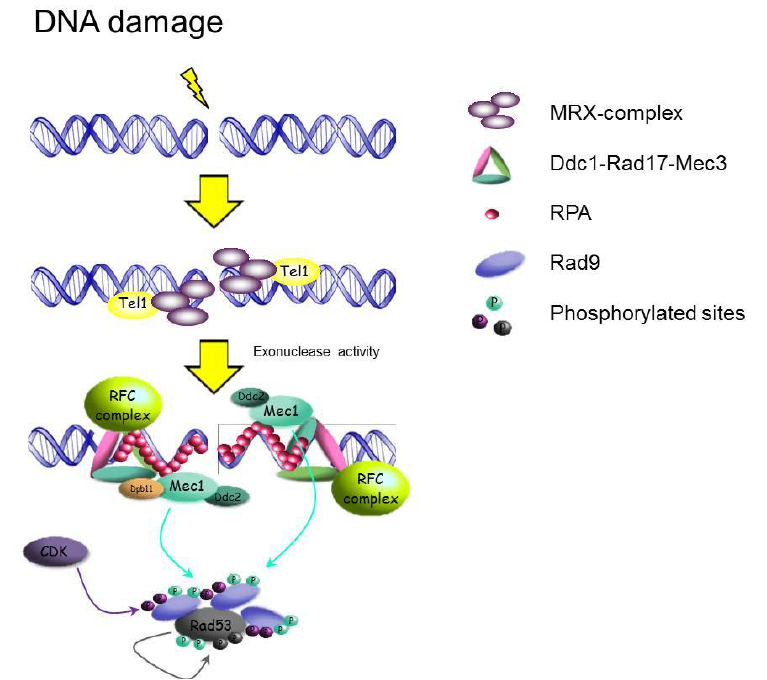
Figure 2. Schematic representation of the DNA damage checkpoint activation pathway in S. cerevisiae after DSBs in G2. For simplicity some factors are